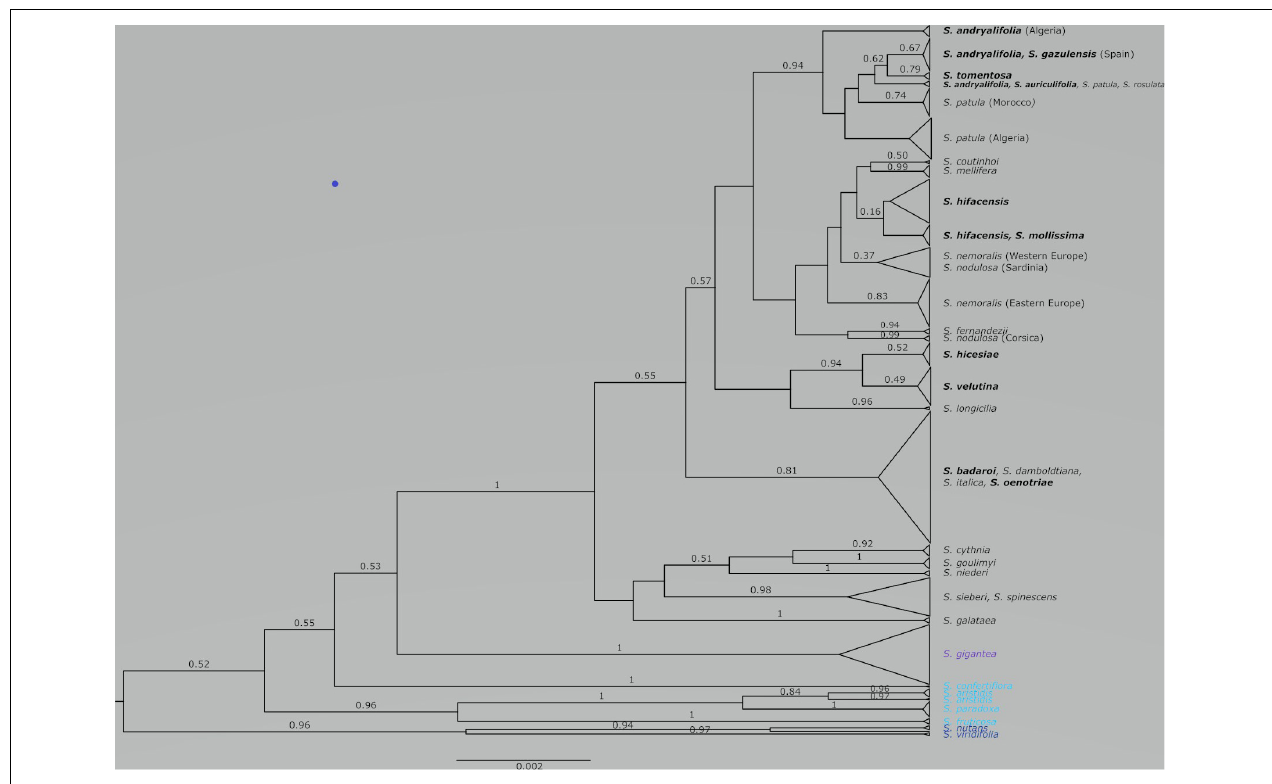
FIGURE 1 | Species tree obtained from the combination of three runs using STACEY on two linked plastid regions ( trn H- psb A and trn S- trn G) and one nuclear marker (ITS). With some exceptions, posterior probabilities that are equal or higher than 0.50 are given above the corresponding branches. The scale at bottom is given in substitutions/site. The chasmophytic species are indicated in bold. The species belonging to Italicae are shown in black whereas the species included in Giganteae , Paradoxae and Siphonomorpha s.s. are shown in violet, blue and dark blue,